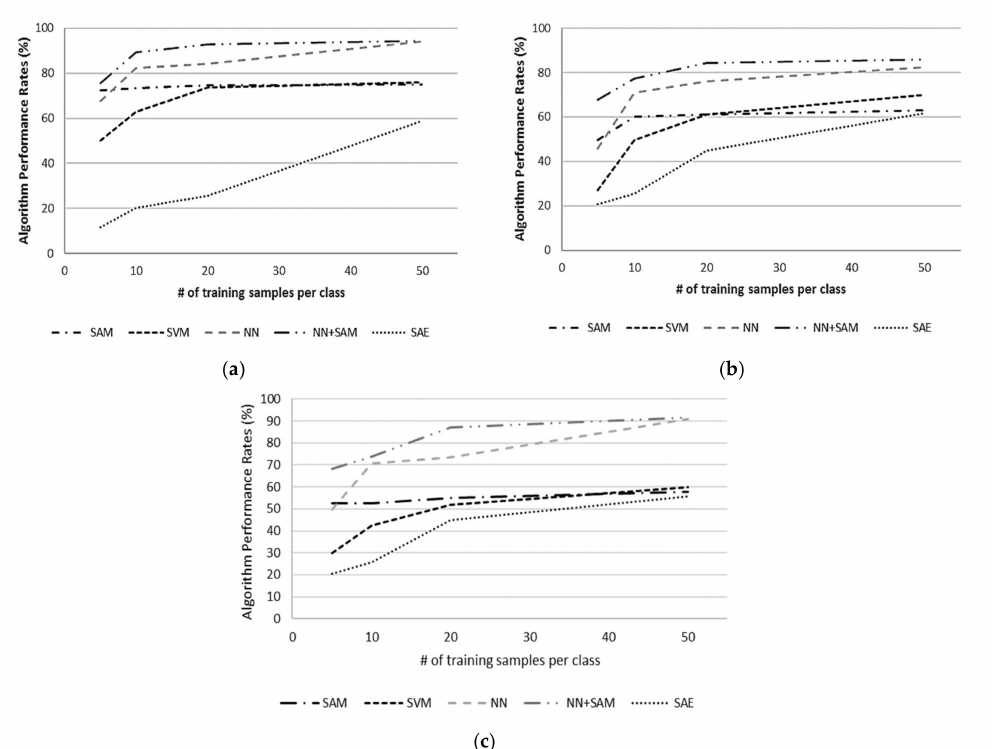
Figure 13. Performance increments of the algorithms for di ff erent training sets: ( a ) Image 1; ( b ) Image 2; and ( c ) Image 3.